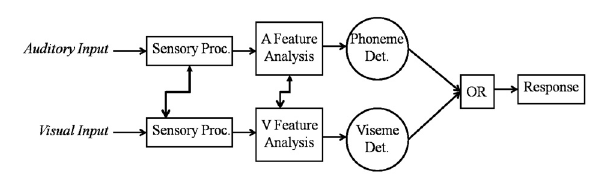
FIGURE 1 | A parallel model of audiovisual recognition with separate detectors for the auditory and visual channels. The model allows for cross-modal interaction in the early and later stages of recognition, although our study primarily focuses on obtaining evidence for later interactions.